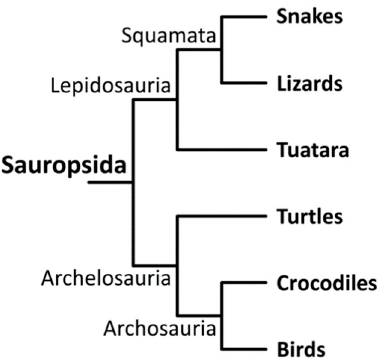
Figure 2. Cladogram of sauropsids. According to Crawford et al. [22] and Gemmell et al. [23] .